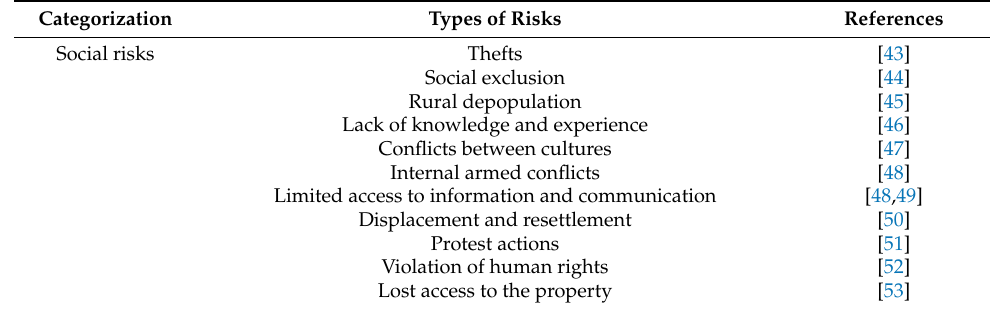
Table 1. List of risks associated with development and management projects through literature